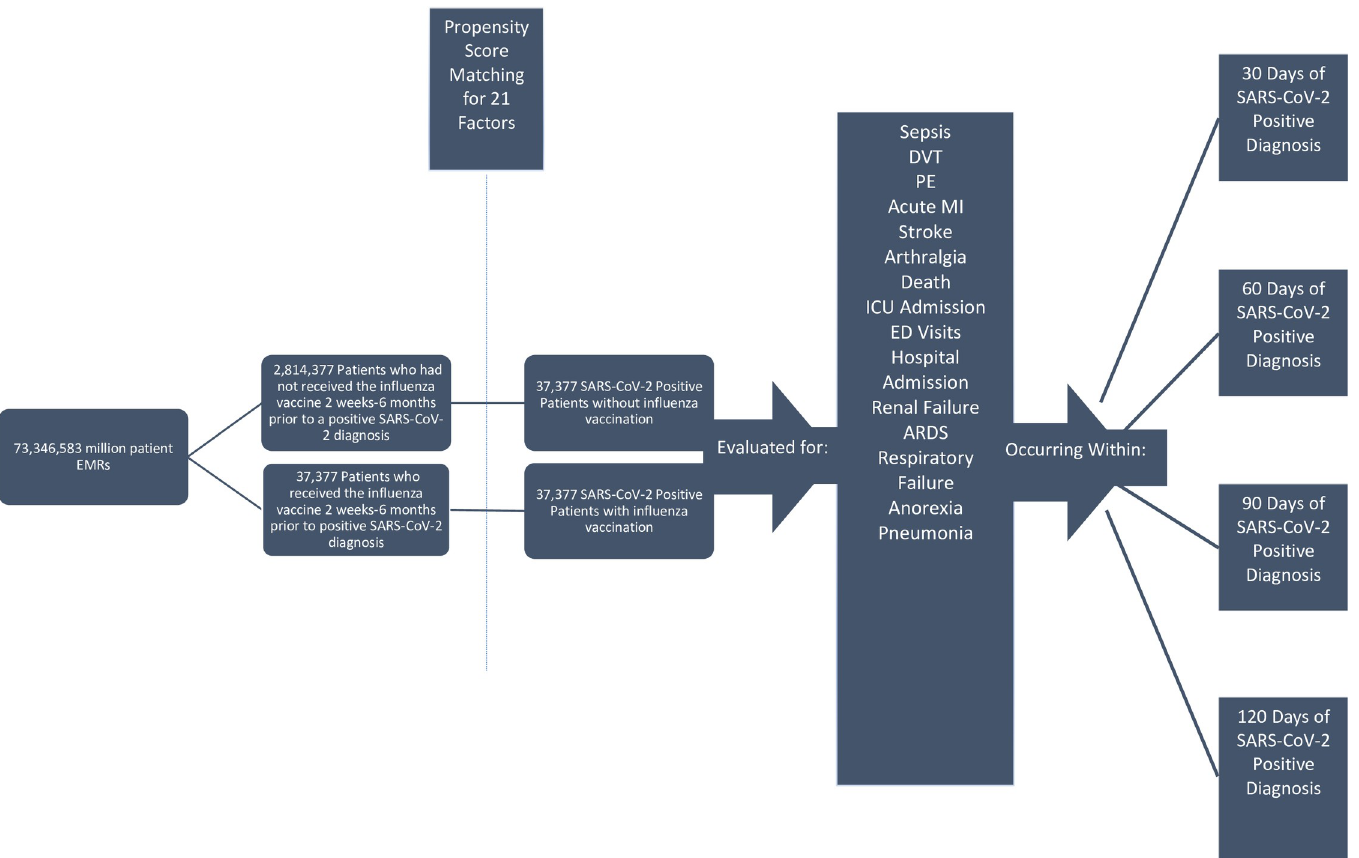
Fig 1. TriNetX search strategy that allowed the authors to narrow down the EMRs of an initial 73,346,583 patients into two propensity score matched 37,377-patient cohorts (N = 74,754) for direct comparison of adverse outcomes within 30, 60, 90, & 120 days of SARS-CoV-2-positive diagnosis.